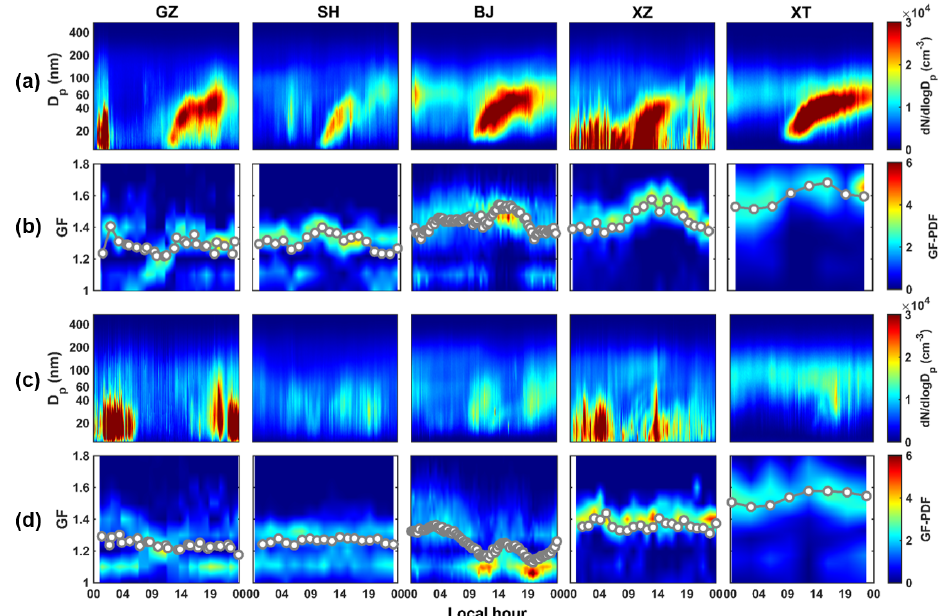
Figure 8. The mean variation in particle number size distributions (PNSDs) and the probability distribution functions of growth factor (GF- PDFs) for 40nm particles during (a–b) NPF and (c–d) non-NPF days at the five sampling sites. The dots in panels (b) and (d) represent the GF mean values.